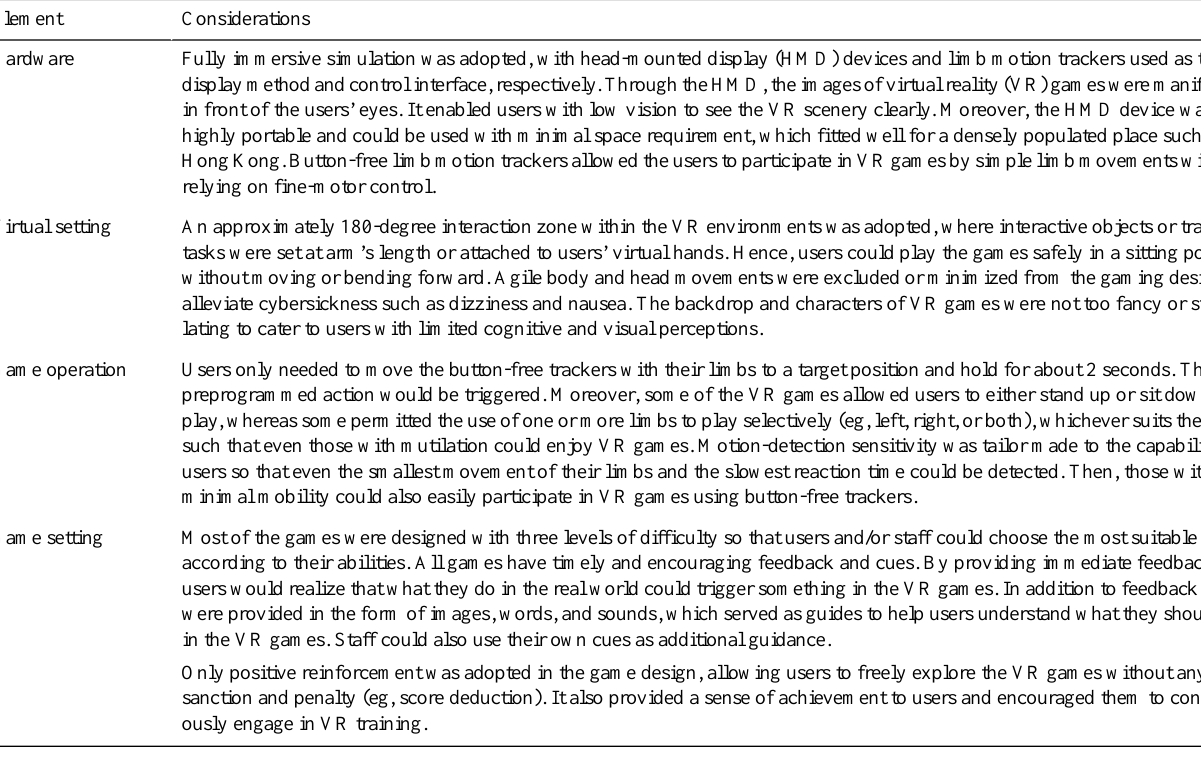
Table 2. Virtual reality games in the training session. Virtual reality (VR)